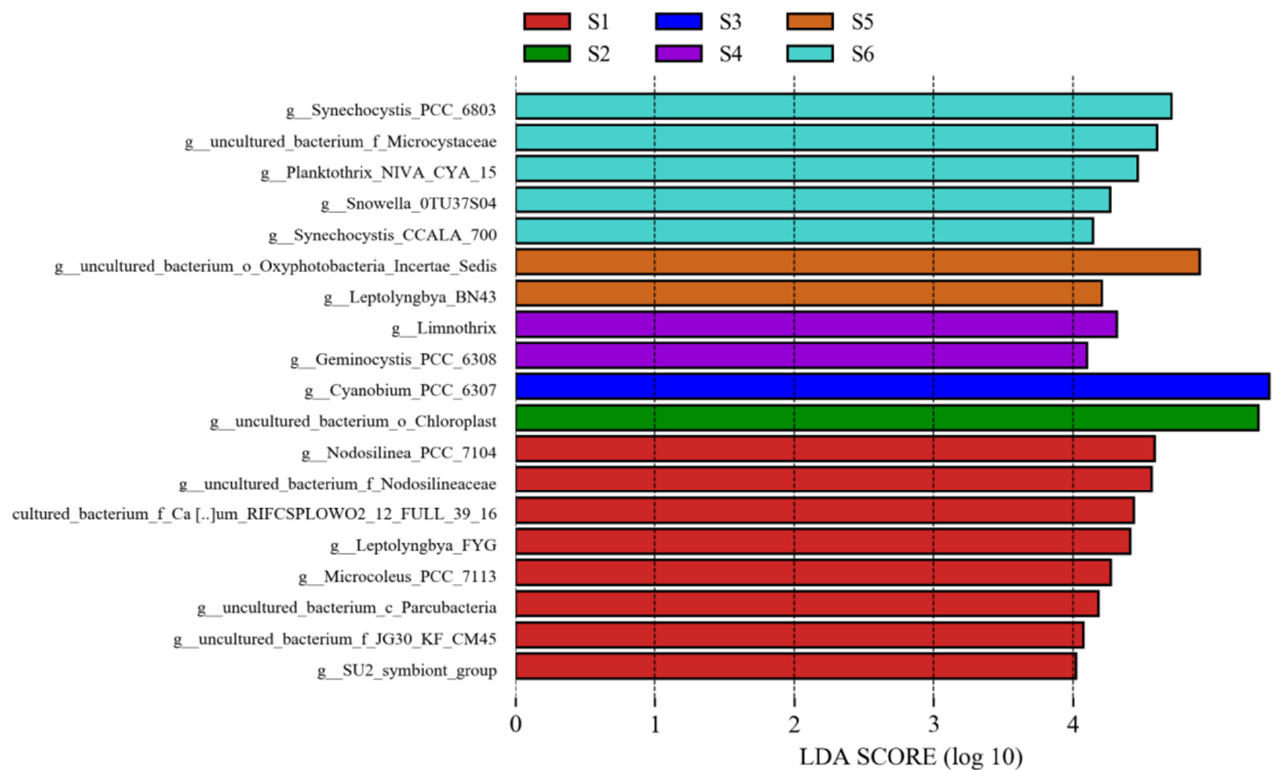
Figure 5. Histogram of the linear discriminant analysis scores of soil bacterial community at genus level. NOTE: p < 0.05, LDA score 4.0.